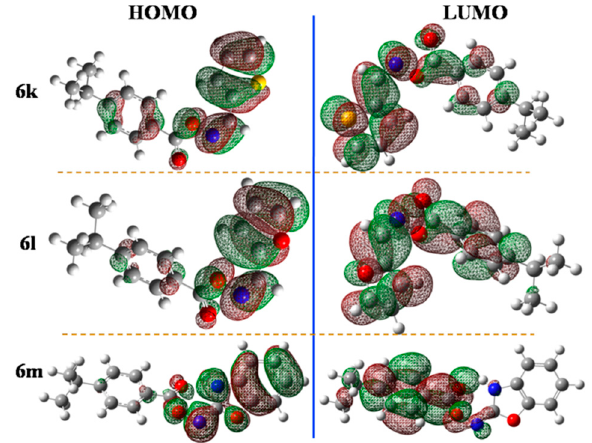
Figure 3. The HOMO and LUMO energy maps for compounds 6k , 6l and 6m .